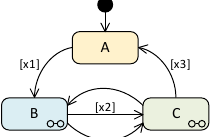
Figure 2. An exemplary state machine diagram (the highest hierarchy level).